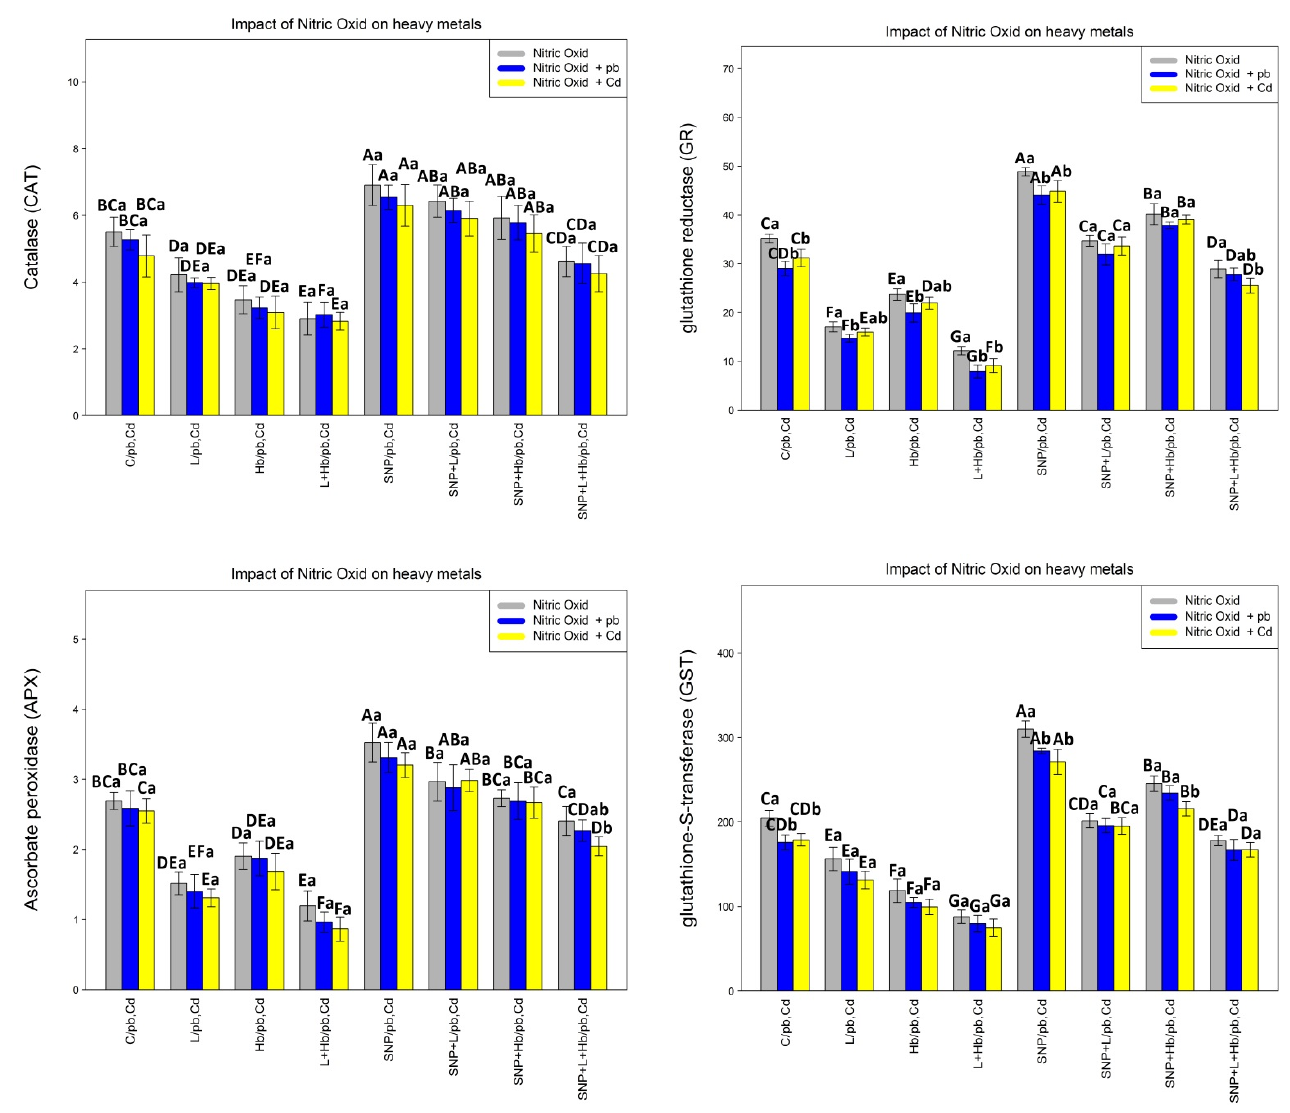
Figure 3. Effect of nitric oxide (NO) concentrations on antioxidant enzyme activities (SOD, POD, CAT, GR, APX and GST), of A. pygmaea L. with 200 µ M Pb and 200 µ M Cd. The treatments contained various concentrations of nitric oxide alone or in combination with 200 µ M Pb and 200 µ M Cd. The capital letters show statistically significant differences across various levels of nitric oxide alone or in combination with 200 µ M Pb and 200 µ M Cd (the bars with the same colors), while the lowercase letters show statistically significant differences within each concentration of nitric oxide (NO) alone or in combination with 200 µ M Pb and 200 µ M Cd (the bars with different colors) according to Tukey’s test ( p < 0.05).